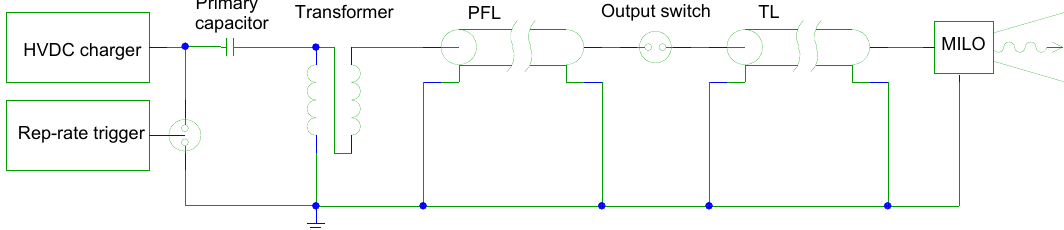
Figure 1. Schematic of the HPM driver.